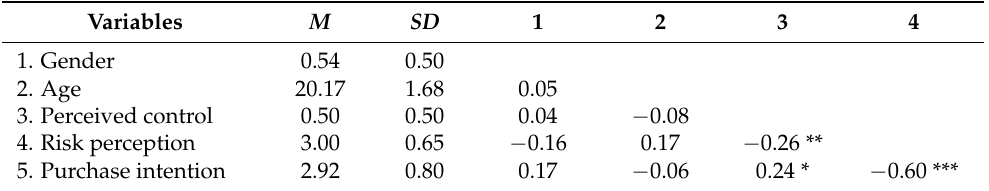
Table 3. Study 2 descriptive statistics and correlations ( N =